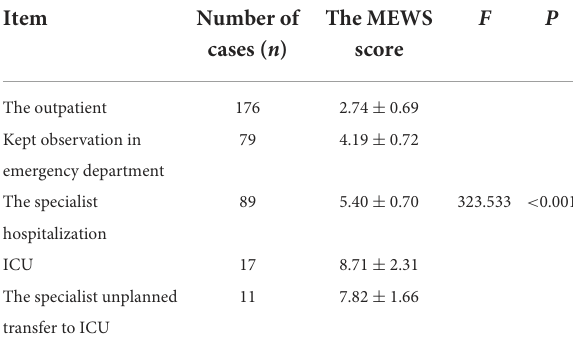
TABLE 4 Results of MEWS score in patients with different referrals ( ¯ X ± s, point).